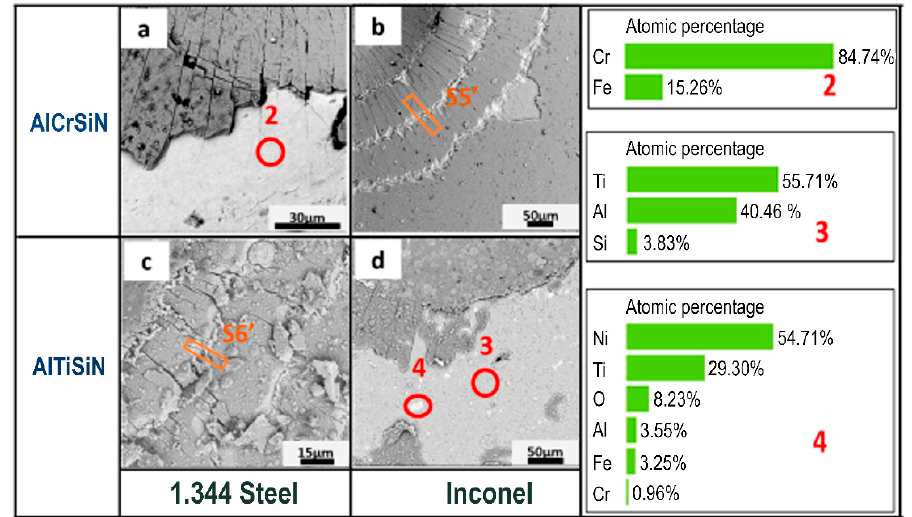
Figure 12 . SEM images of the Mercedes test and EDX analysis at 613 N with a Rockwell C tip after 800 °C treatment: ( a ) AlCrSiN/steel, ( b ) AlCrSiN/Inconel, ( c ) AlTiSiN/steel, and ( d ) AlTiSiN/Inconel. Numbers 2m3 and 4 indicate the chemical analysis by EDS. S5’ and S6’ indicate the FIB cross-sections as presented in Figure 13.